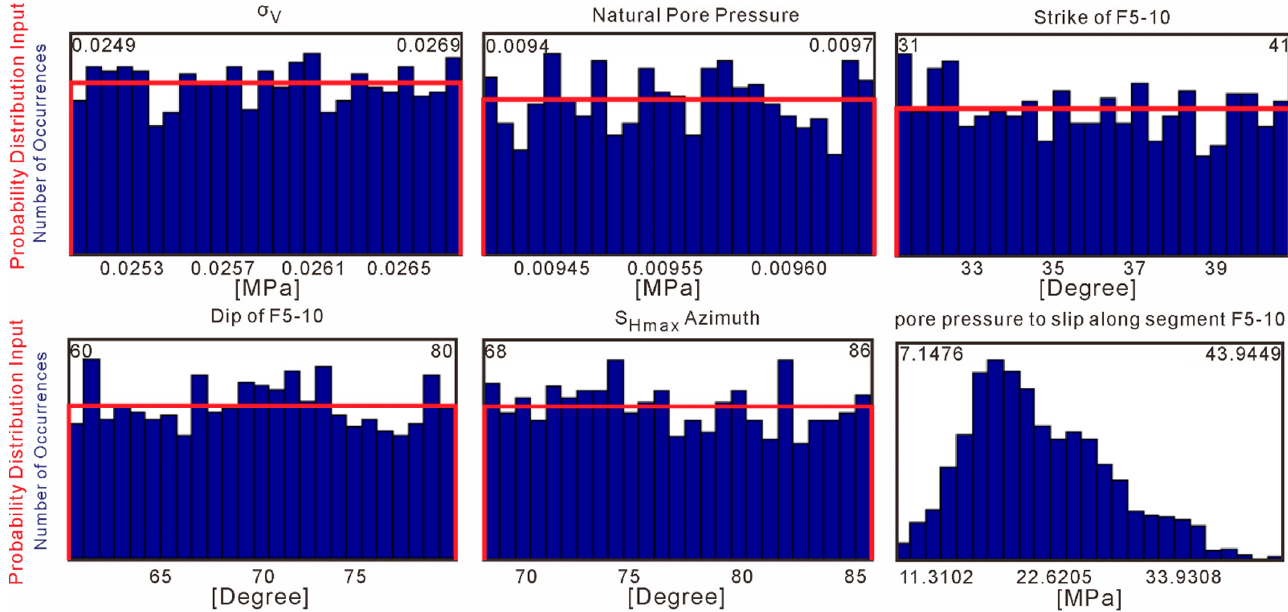
Figure 5. Probability distributions of the hydraulic uncertainties on segment F5-10 in 2021. Uniform distributions of each parameter uncertainty are plotted in red, with bounds labeled in the upper corners of each plot. Each blue histogram shows the actual distribution of each randomly input after many Monte Calo iterations.